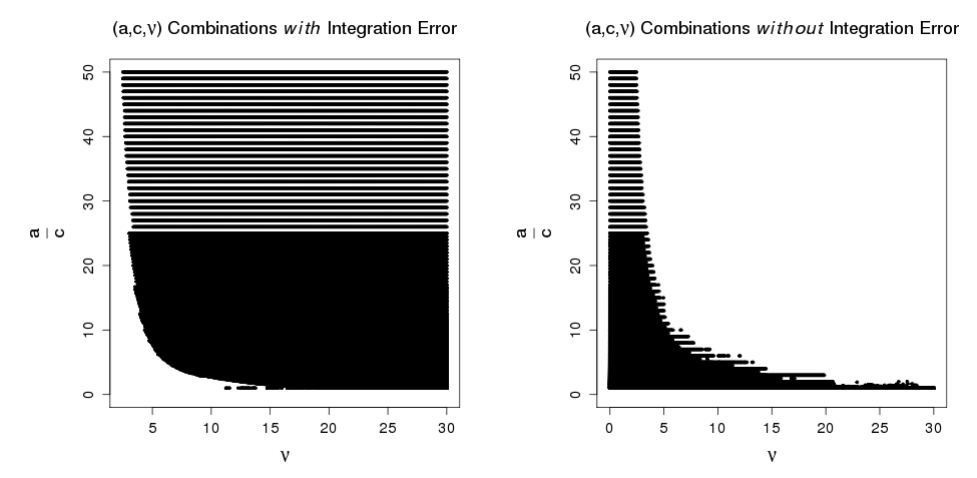
Figure 2. Empirical illustration of parameter constraints for conditional conjugate density h ( λ | ν ) . κ − 1 ( a , c ) is evaluated over a ∈ ( 0.1,5 ) , c ∈ ( 0.1,5 ) by 0.1 and ν ∈ ( 0,30 ) by 0.05 for a > c